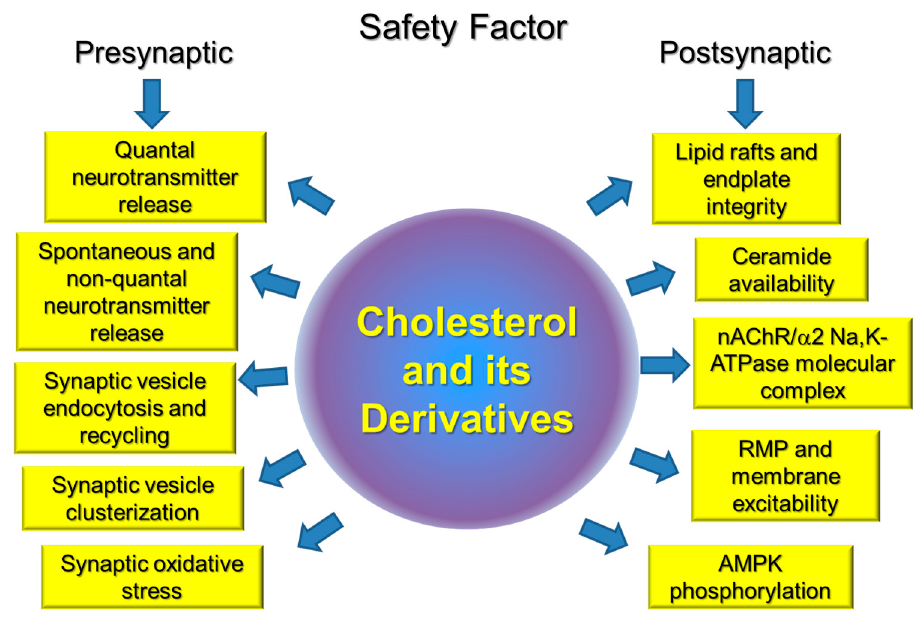
Figure 3. Key pre- and postsynaptic points that cross-talked with plasma membrane cholesterol and are responsible for the safety factor at the neuromuscular junction (NMJ).